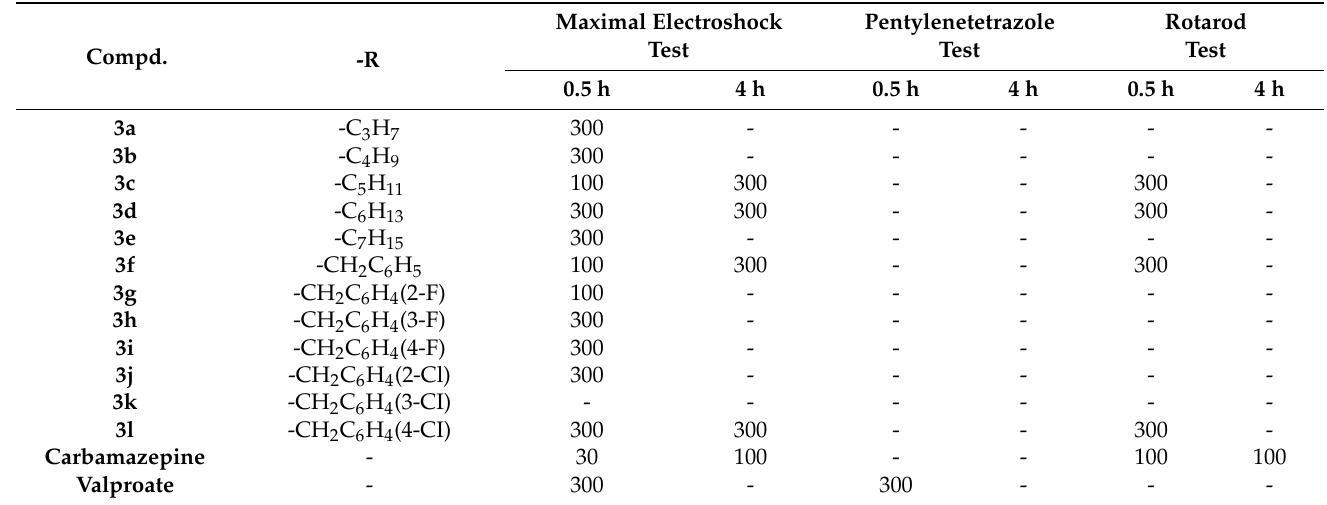
Table 1. Antiseizure and neurotoxic effects of the target compounds ( 3a – l ) after a single intraperi- toneal injection in mice a